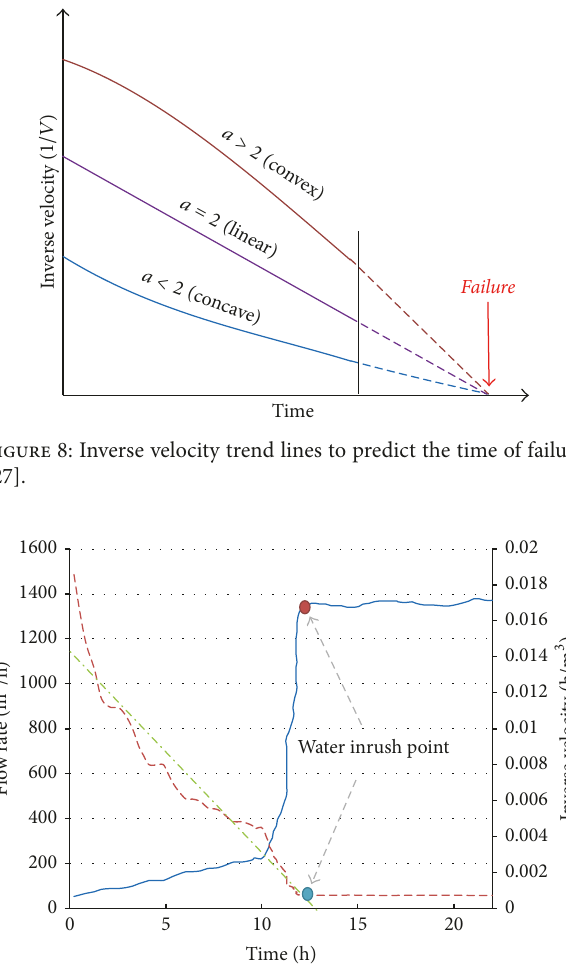
Figure 9: Verification of the inverse velocity theory in predicting water inrush.